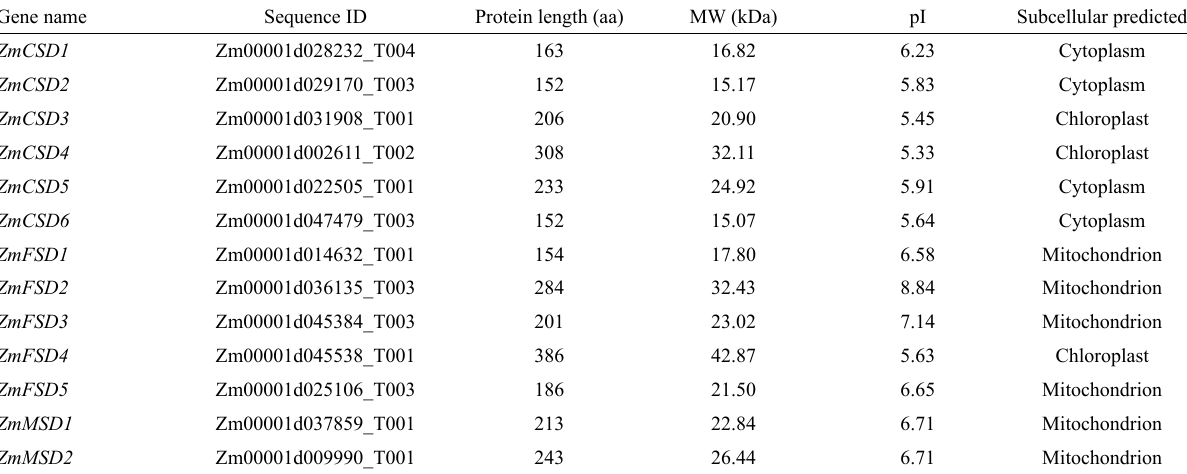
Table 1 ‒ Sequence characteristics of the 13 SOD genes identified in